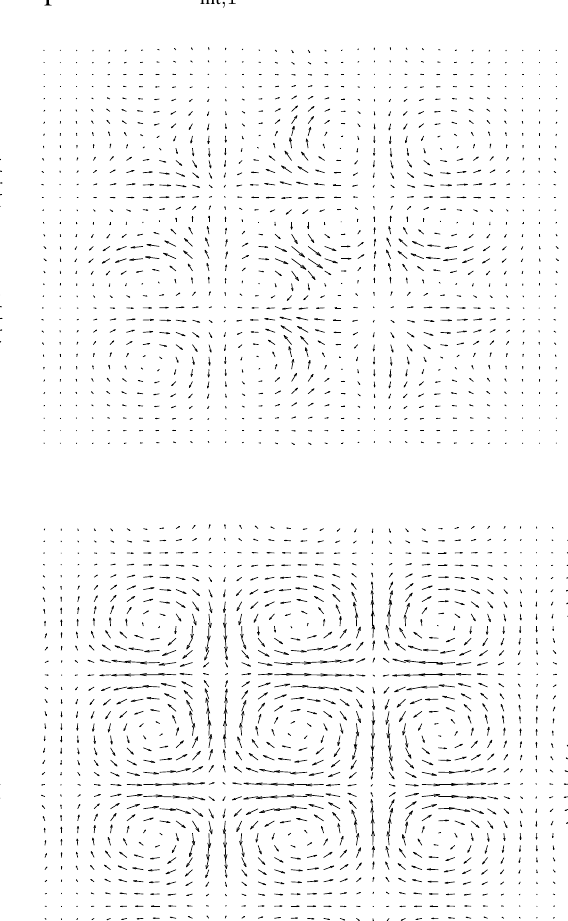
(cid:126) ˜ Ψ int , 1